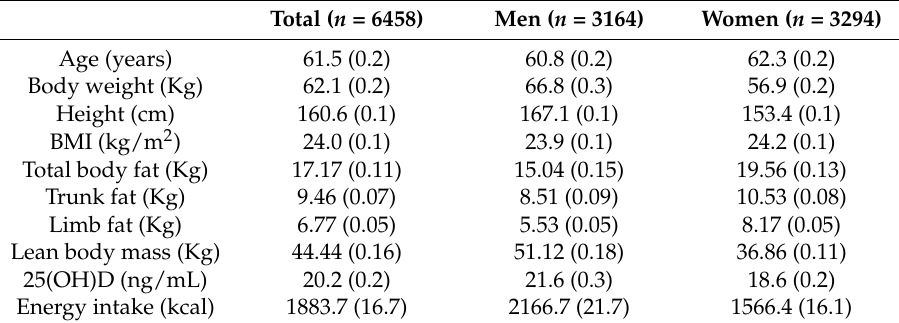
Table 1. General characteristics of study subjects.